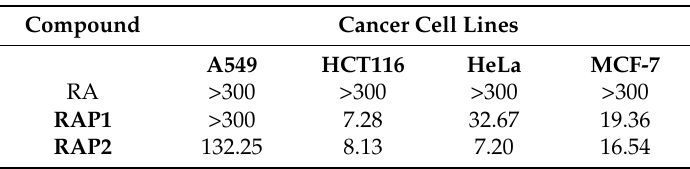
Table 1. The IC 50 ( µ M) values of RA and its phosphonium salts RAP1 and RAP2 in different cell lines after 72 h incubation.